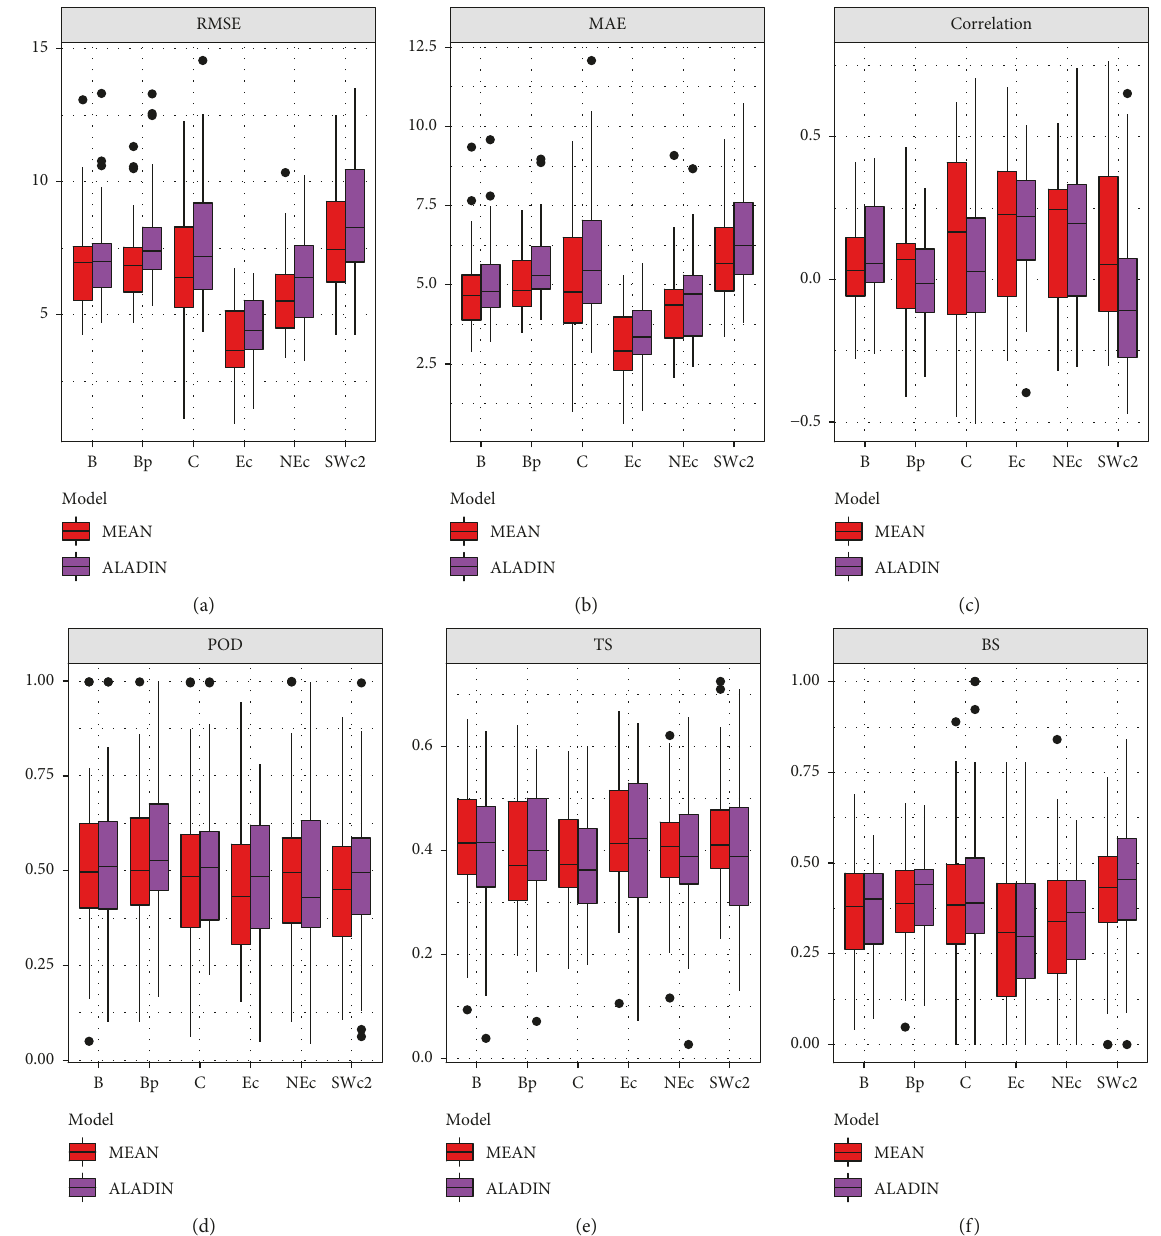
Figure 8: Boxplots of RMSE (a), MAE (b), COR (c), POD (d), TS (e), and BS (f) dependence on weather types. ALADIN results are plotted with purple boxes, MEAN with red